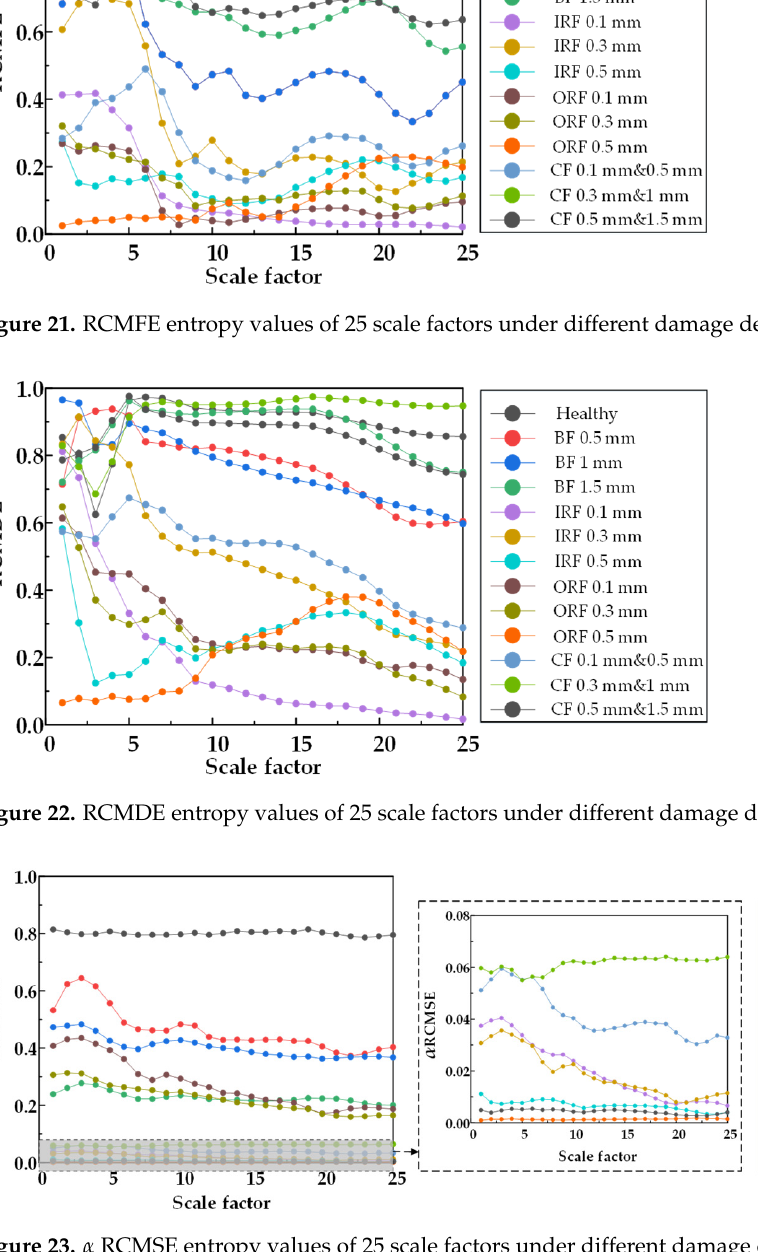
Figure 24. α RCMFE entropy values of 25 scale factors under different damage degrees.